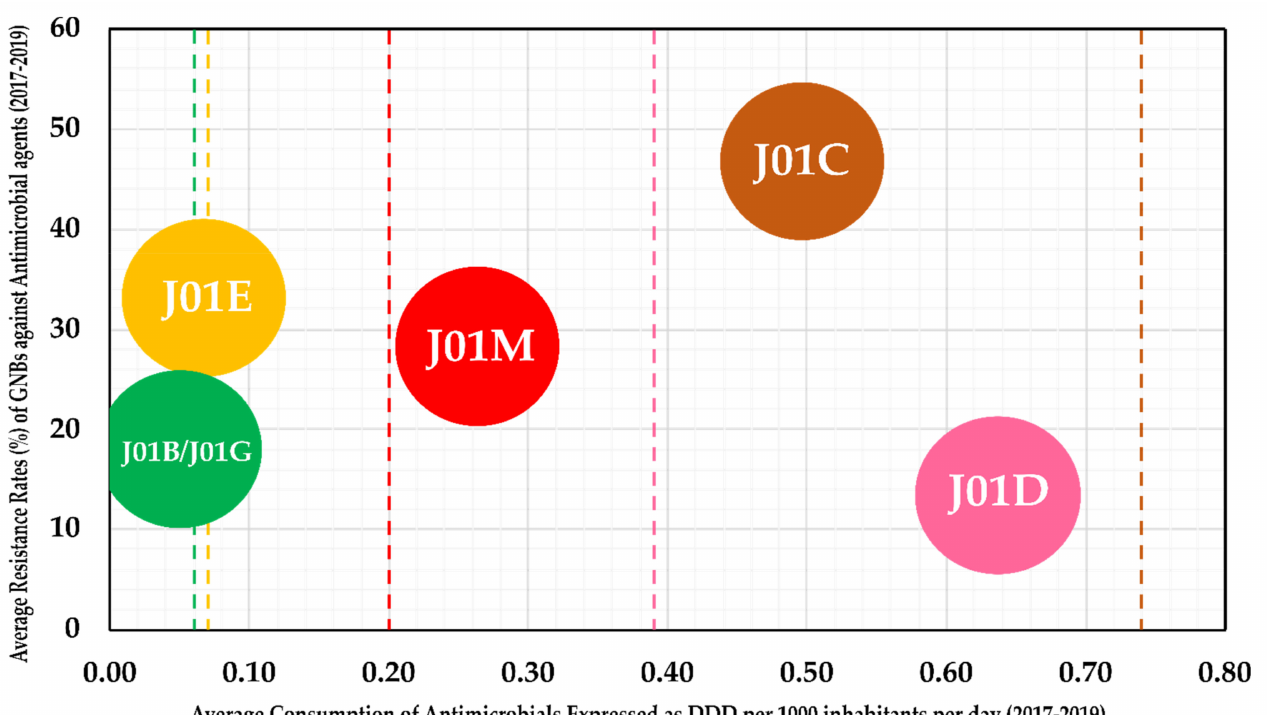
Figure 4. Average consumption rates of antimicrobials expressed as DDD (defined daily dose) per 1000 inhabitants per day (x-axis) against the average resistance rates of GNBs obtained in the present study (y-axis). Antimicrobials were classified based on WHO’s Anatomical Therapeutic Chemical Classification System—J01B includes CHL; J01G includes AMK and GEN; J01E includes SXT; J01M includes CIP; J01C includes AMC, AMP and TPZ; J01D includes CAZ, CTX, ETP, IPM and MEM. The colored lines indicate the respective group average for EEA/EU (European Economic Area/European